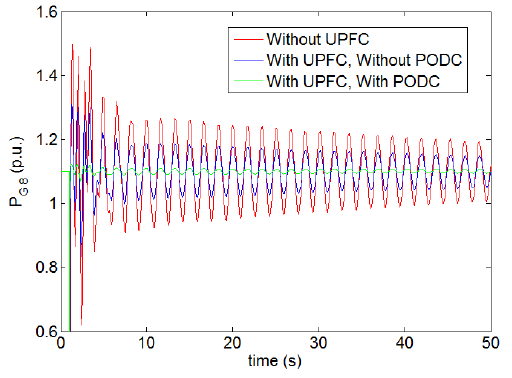
Figure 12. Active power output curves of G 8 .